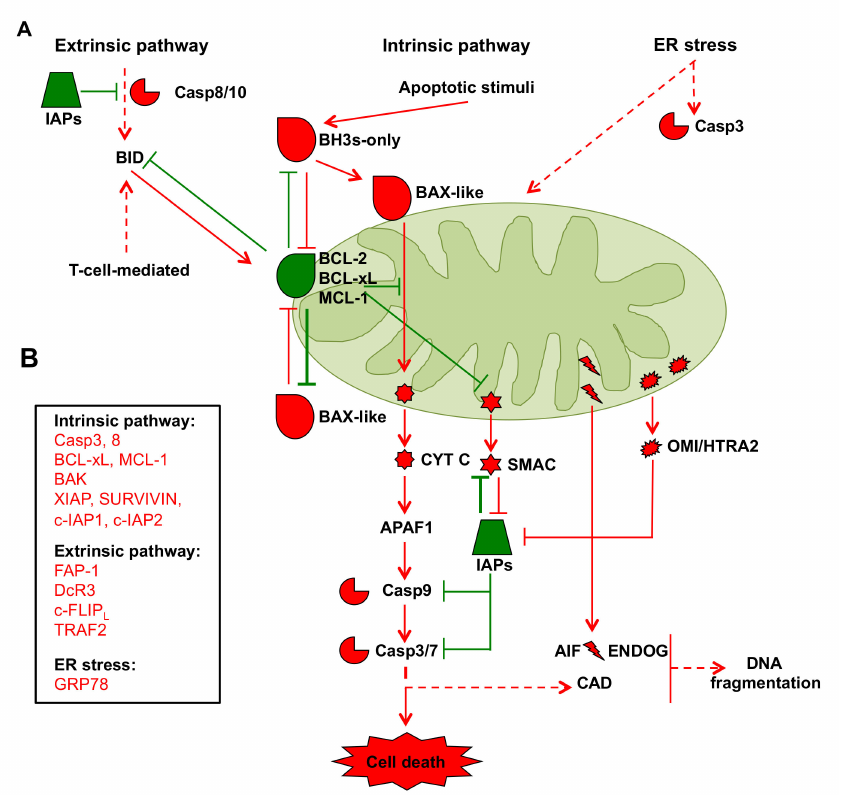
Figure 2. ( A ) Schematic view of apoptotic mechanisms. Green lines and shapes: antiapoptotic pro- teins and mechanisms; red lines and shapes: proapoptotic proteins and mechanisms. ( B ) Apoptosis- related proteins overexpressed in PC. Fas-associated phosphatase-1 (FAP-1), decoy receptor 3 (DcR3), Cellular FADD-like IL-1 β -converting enzyme (FLICE)-inhibitory protein (c-FLIPL), TNF receptor associated factor 2 (TRAF2), glucose-regulated protein 78 kDa